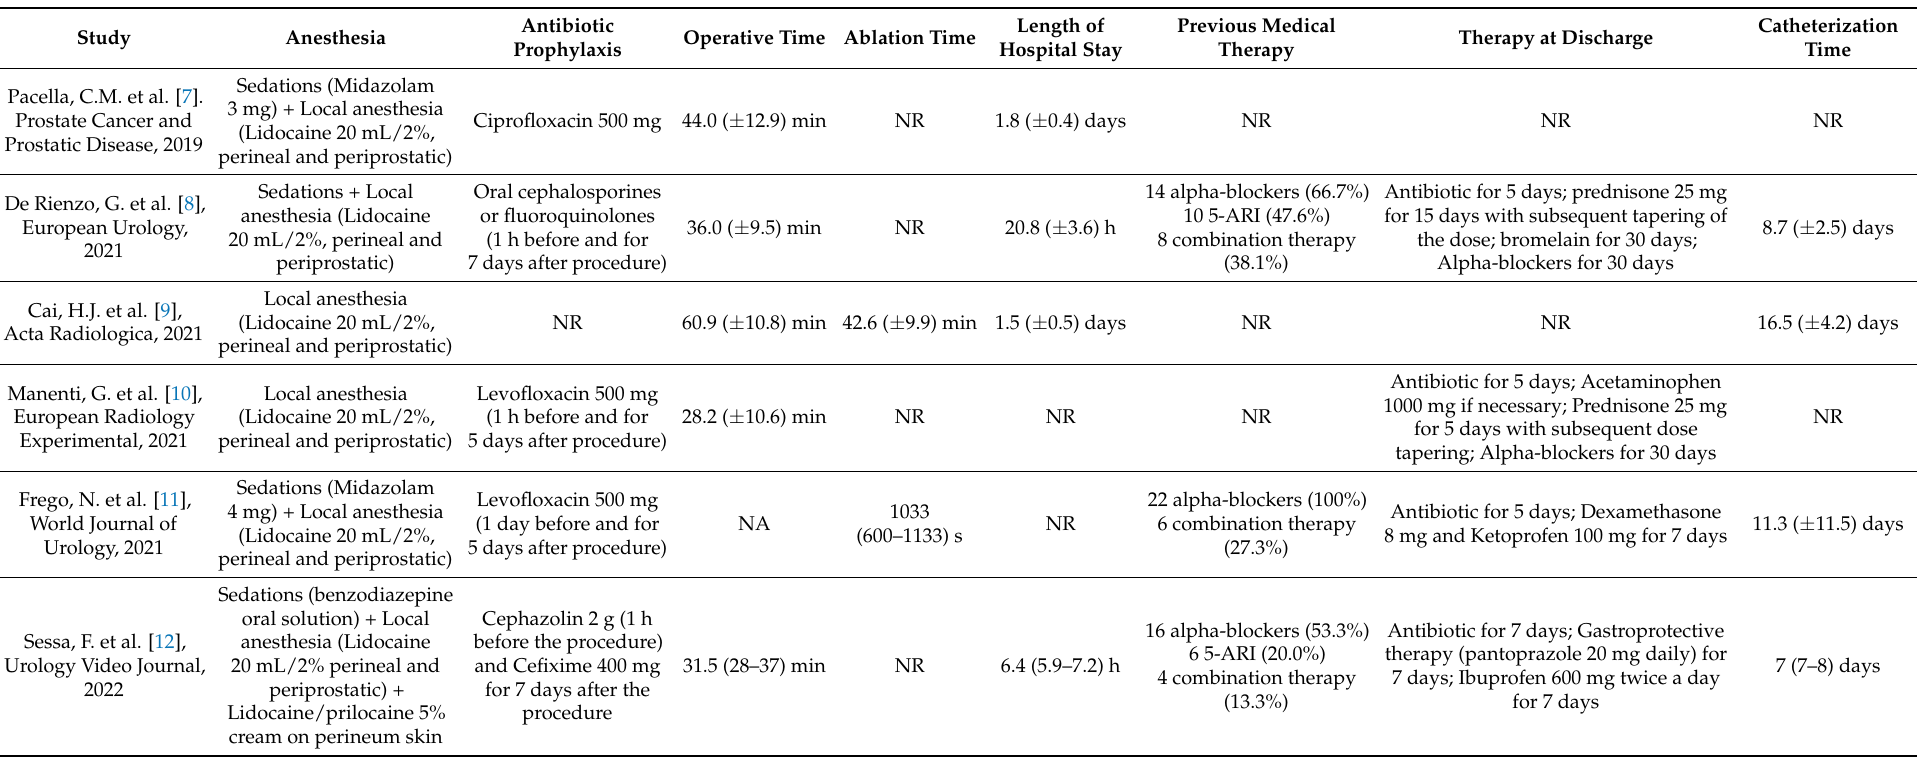
Table 3. Summary of the main perioperative features of transperineal laser ablation (TPLA) for benign prostatic enlargement (BPE) in all the six included